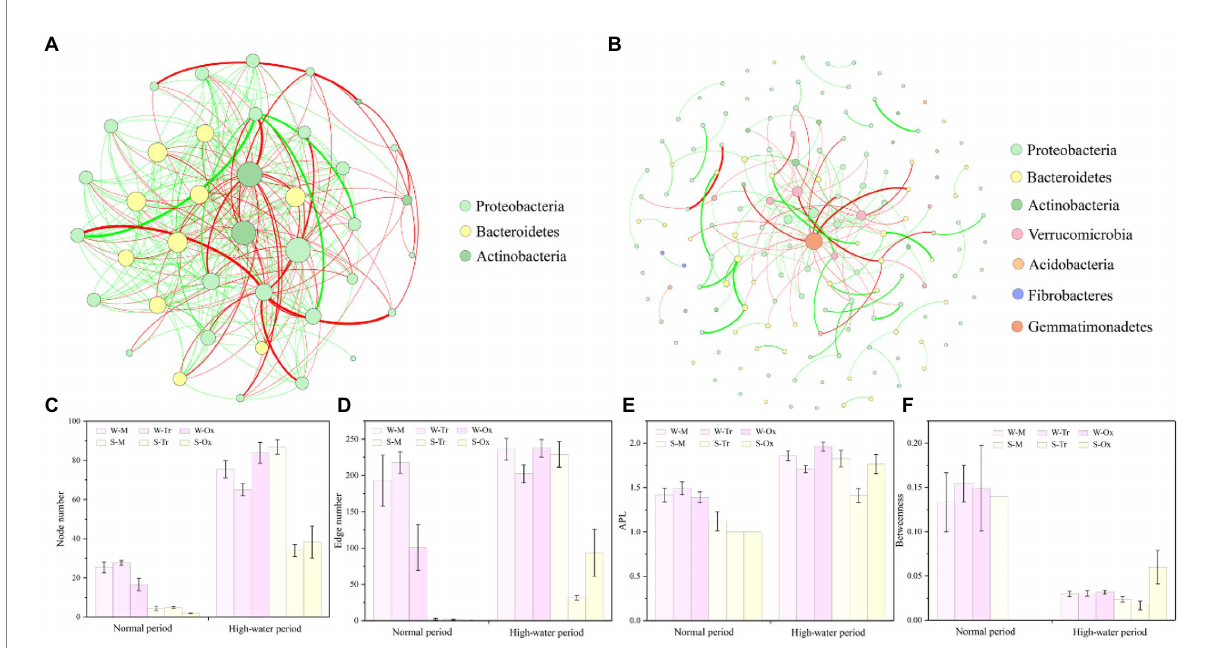
FIGURE 8 Co-occurrence networks of bacterial communities and topological features of sub-networks. Bacterial networks in the (A) normal and (B) high- water periods were constructed at the phylum level. The network topology was characterized using (C) node number, (D) edge number, (E) average path length (APL) and (F) betweenness. W-M, water-mainstream; W-Tr, water-tributaries; W-Ox, water-oxbow lakes; S-M, sediment- mainstream; S-Tr, sediment-tributaries; and S-Ox, sediment-oxbow